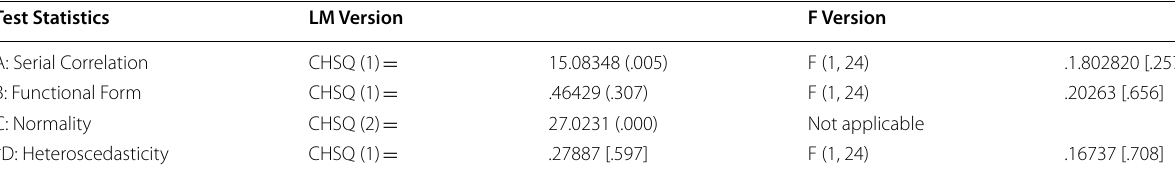
Table 8 Model goodness of fit and model diagnostic tests